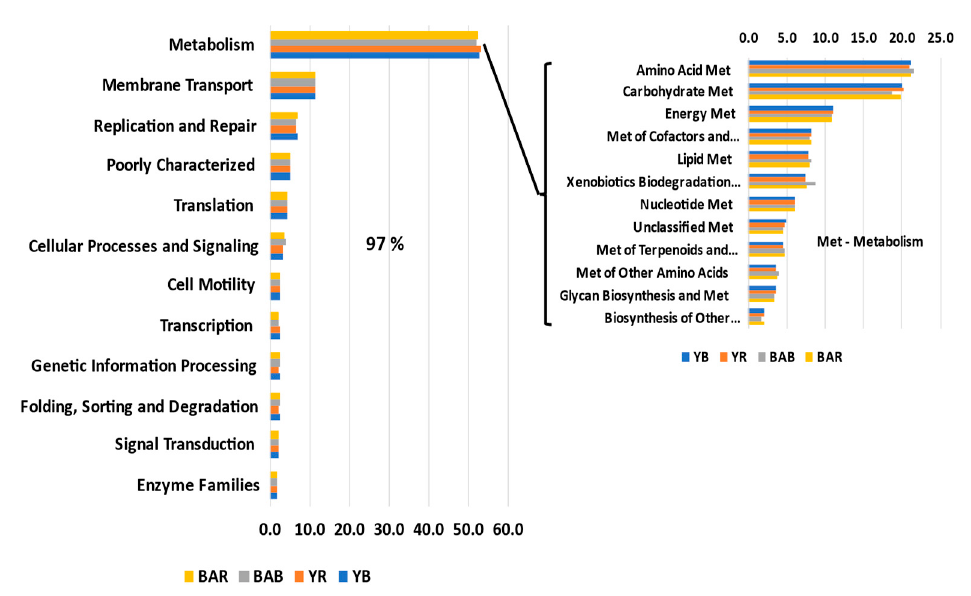
Figure 5. Functional predictions of all samples from different agro-management: organic (Y) and conventional (Ba); and at different sampling locations: between (B) the plant rows and in the vine rows (R) using PICRUSt. Table 3. Table describing the bacterial community functions divided into three groups: a. Subdom- inant, b. Dominant, and c. Submediant.